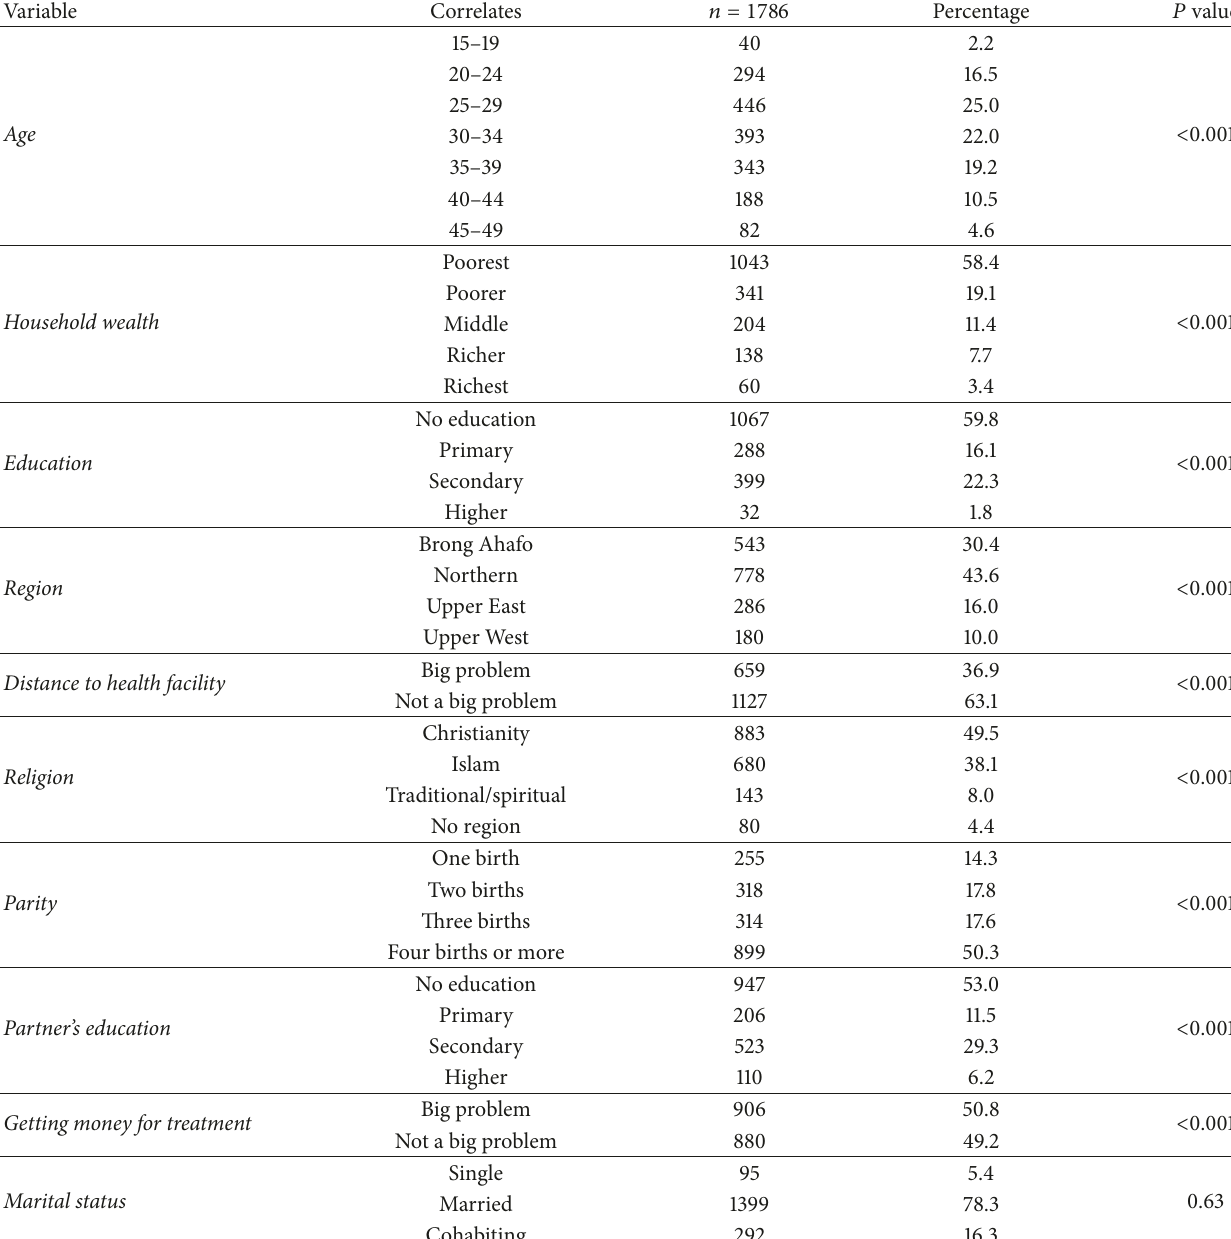
Table 1: Background